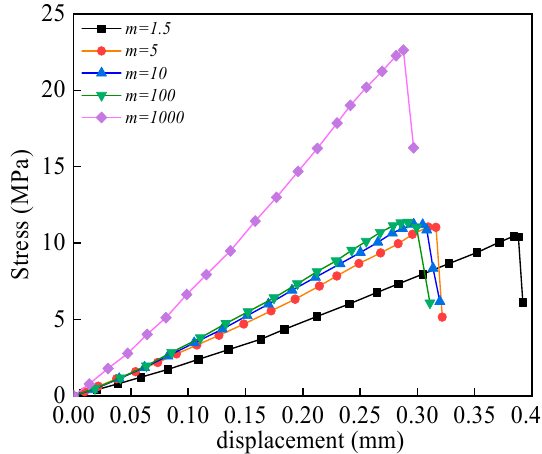
1.64 1.66 1.68 1.70 1.72 1.74 1.76 1.78 Figure 14. Relationship of D and Brazilian strength and m . Figure 14. Relationship of D and Brazilian strength and m . The stress–displacement curves of the rock specimens with different homogeneities are shown in Figure 15. The rock specimens with 1.5 ≤ m ≤ 100 under Brazilian splitting load all underwent the three stages of linear elasticity, yielding, and post-peak. The difference among all the stress–displacement curves is that their yielding phase becomes shorter with the increase in homogeneity. When 5 ≤ m ≤ 100, the stress–displacement curves almost coincided. When m is greater than 1000, the yield phase is almost unrecognizable, and the rock sample breaks directly after the linear elastic phase. Regardless of the homogeneity of the rock, brittle damage is evident under Brazilian splitting loads.